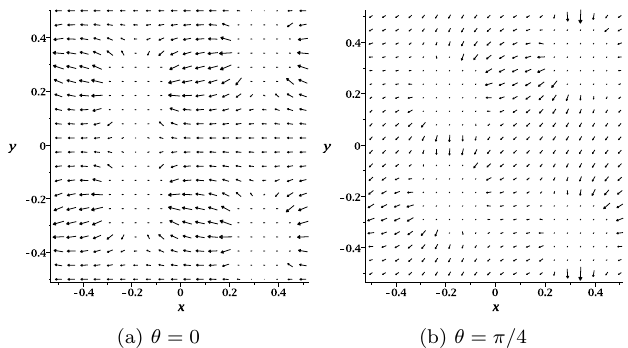
Figure 10. The flux distribution inside Q (0 , 0) for λ k = 100, γ k = 100, β k = − 100, θ = 0; π/ 4.